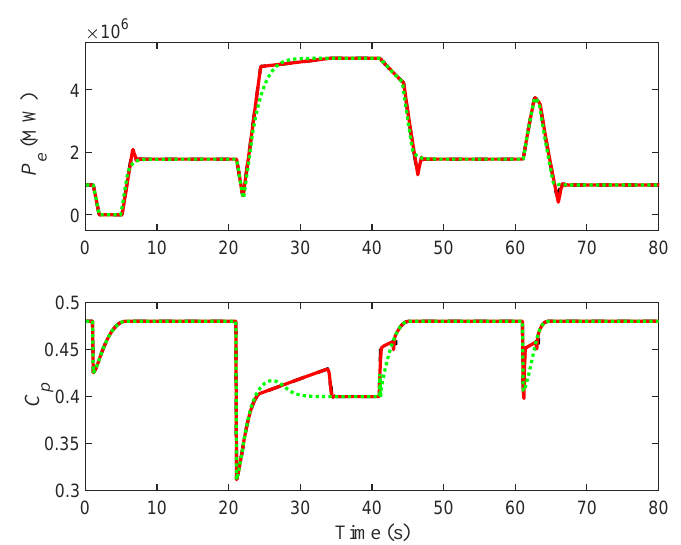
Figure 9. Three-dimensional graph of C p .